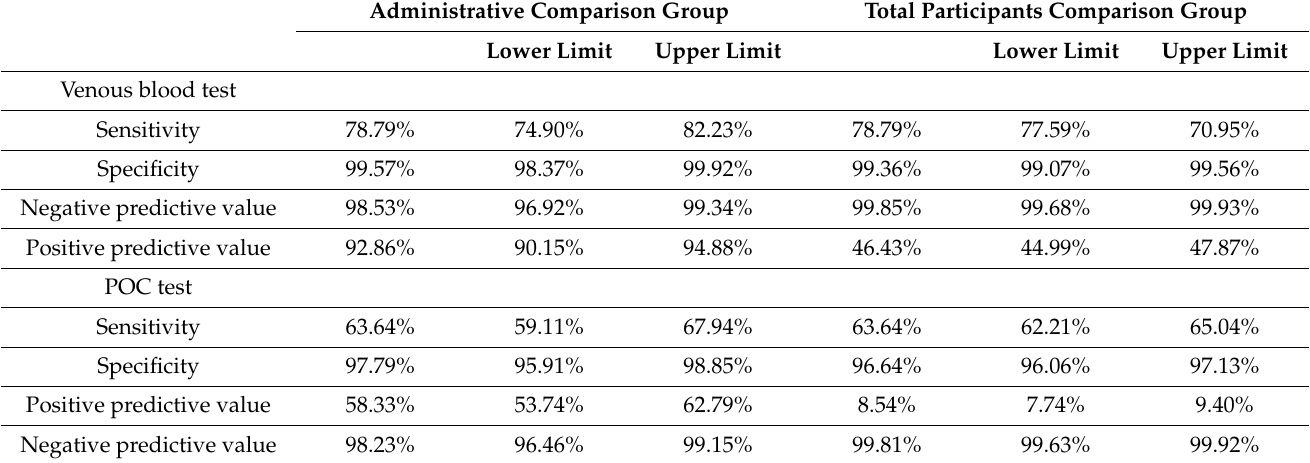
Table 3. Diagnostic parameters for the POC and venous blood tests stratified with both the administrative staff (AS) and total participants as comparison